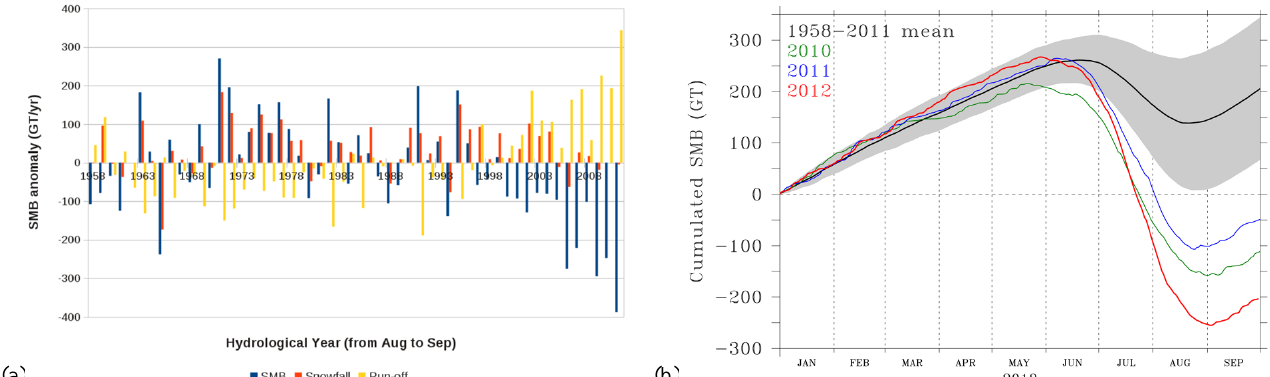
Fig. 5. (a) Bar plot of annual time series of the GrIS SMB, snowfall and runoff anomalies integrated over the hydrological year simulated by MAR, forced by ERA-40 over 1958–1978 and by ERA-INTERIM over 1979–2012. Units are Gtyr − 1 and anomalies are given with respect to the 1958–2011 period. (b) Daily time series of the cumulative SMB (Gtyr − 1 ) using 1 January as a reference for 2012 (dark blue), 2011 (light red) and 2010 (green) and for the 1958–2011 mean (50%